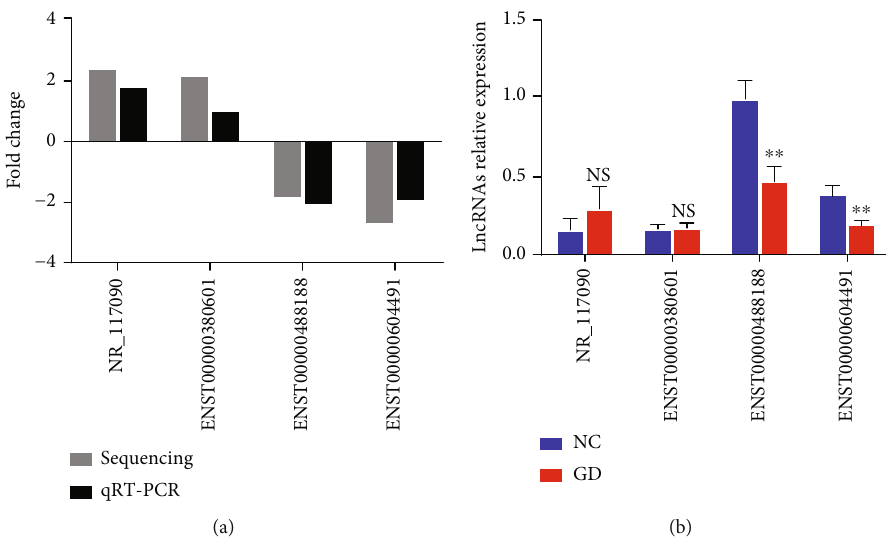
Figure 4: Validation of the selected lncRNAs. PBMCs were obtained from 26 GD patients and 27 normal controls. (a) The fold change of four selected lncRNAs between sequencing data and veri fi ed results by qRT-PCR. (b) qRT-PCR analysis of the expression of NR_117090, ENST00000380601, ENST00000488188, and ENST00000604491. ∗∗ p < 0 : 01